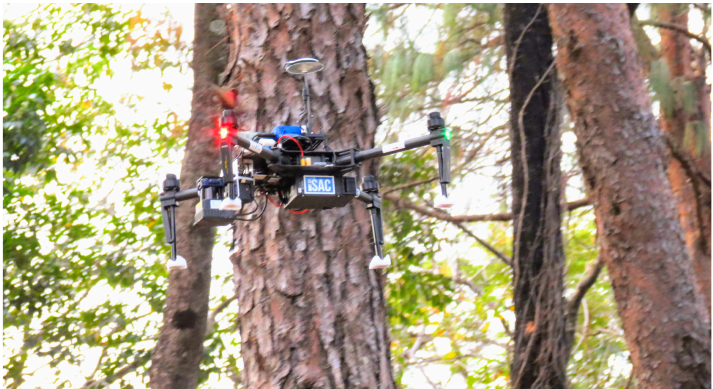
Figure 1. Aerial vehicle used in this work flying in a sparse